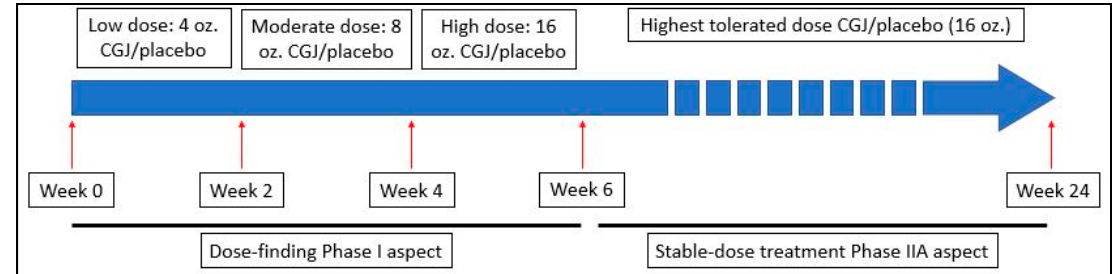
Figure 1. Timeline for the execution of the dose-finding and stable-dose treatment phases. CGJ— Concord Grape